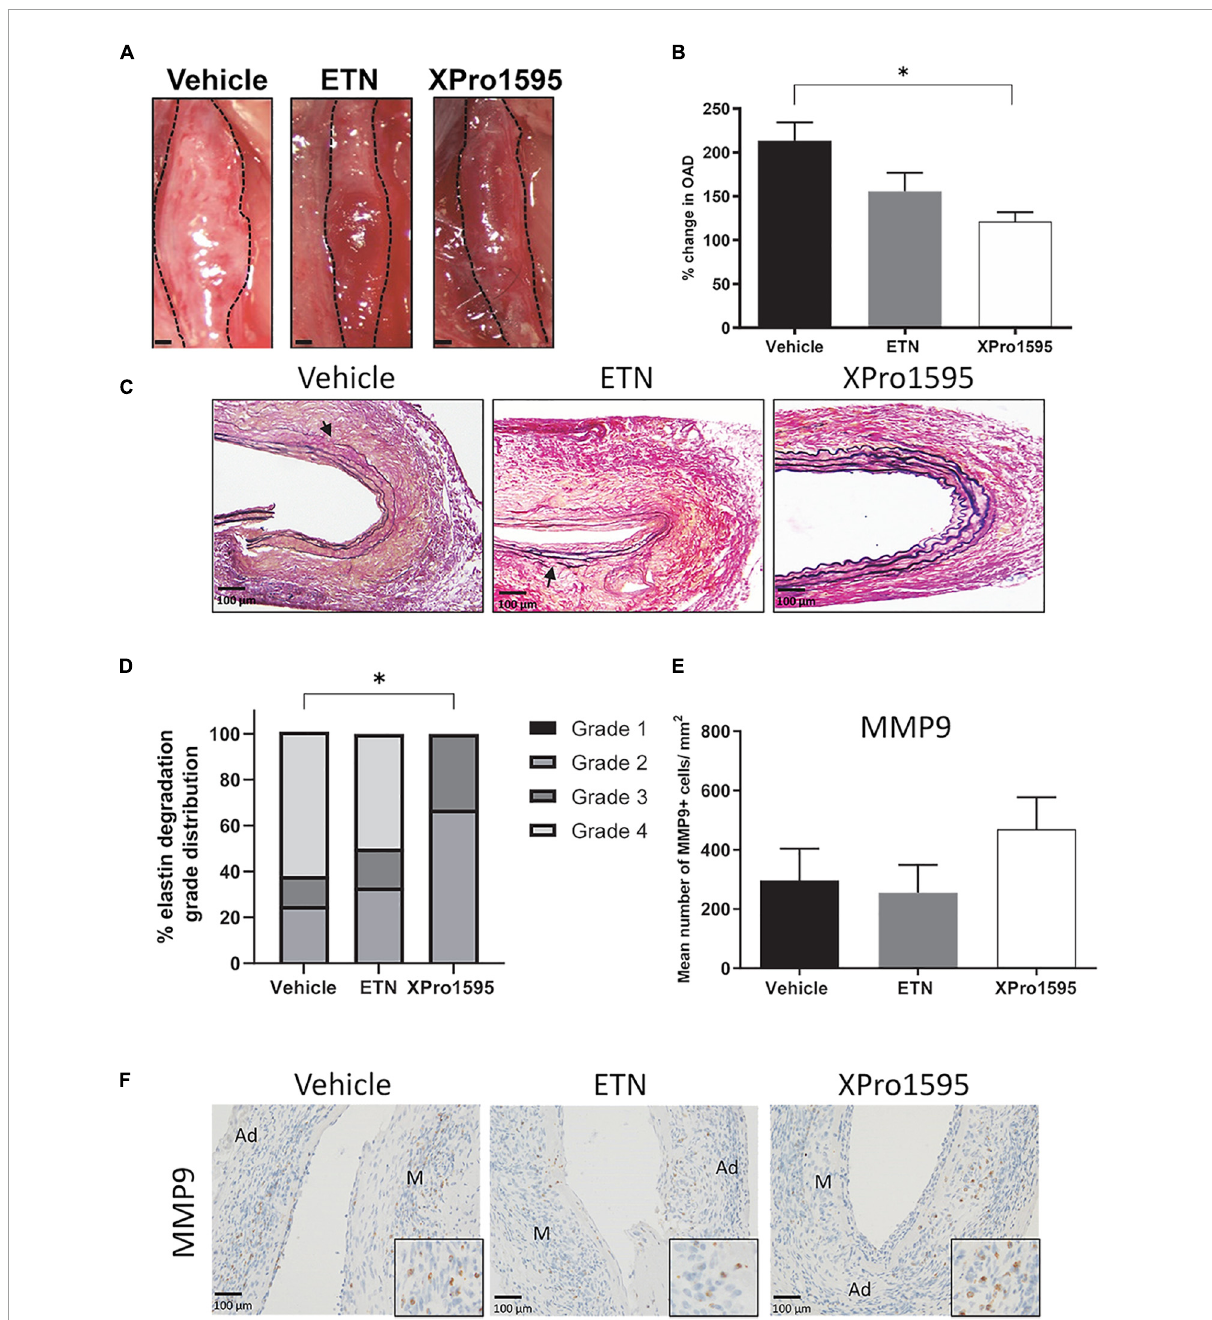
FIGURE1 Selective inhibition of solTNF prevents expansion in PPE-induced AAA. (A) Representative macroscopic images displaying PPE-induced AAAs after 14 days of treatment with vehicle (saline), ETN (20 mg/kg), or XPro1595 (20 mg/kg). (B) In vivo AAA expansion measured as percentage change in the maximal outer diameter of the abdominal aorta (OAD) from day 0 to day 14 ( n = 15–16). (C) AAA cross-sections stained with Miller’s elastic stain (black) after TNF inhibition ( n = 3–5). Breaks in elastic fibers are marked with arrows. (D) Percentage distribution of elastic fiber integrity (grades 1–4) according to treatment groups ( n = 3–5). (E,F) The number of MMP-9-positive cells/mm 2 cross-sectional aneurysmal area from mice treated with vehicle-, ETN-, or XPro1595 ( n = 3–5). Data are shown as mean SEM. * Indicates p < 0.05 analyzed by one-way ANOVA using Bonferroni test for multiple comparisons. Contingency table data in E was analyzed by Fisher exact probability test with Freeman-Halton extension. M, media; Ad,